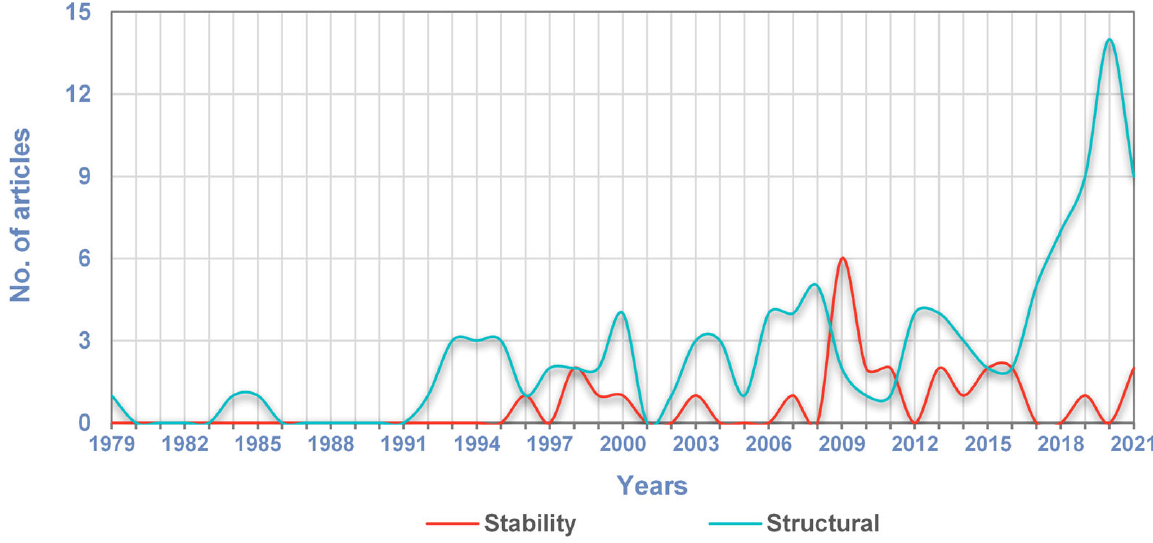
Figure 2. Trend in the annual distribution of literature related to the structure and stability of agroforestry ecosystems.